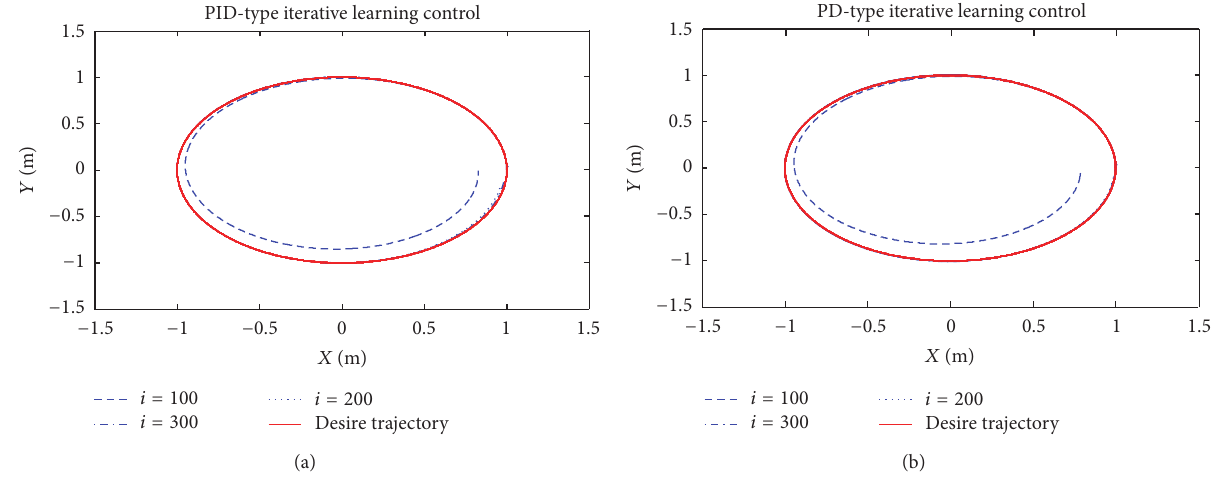
Figure 2: Desired and actual position